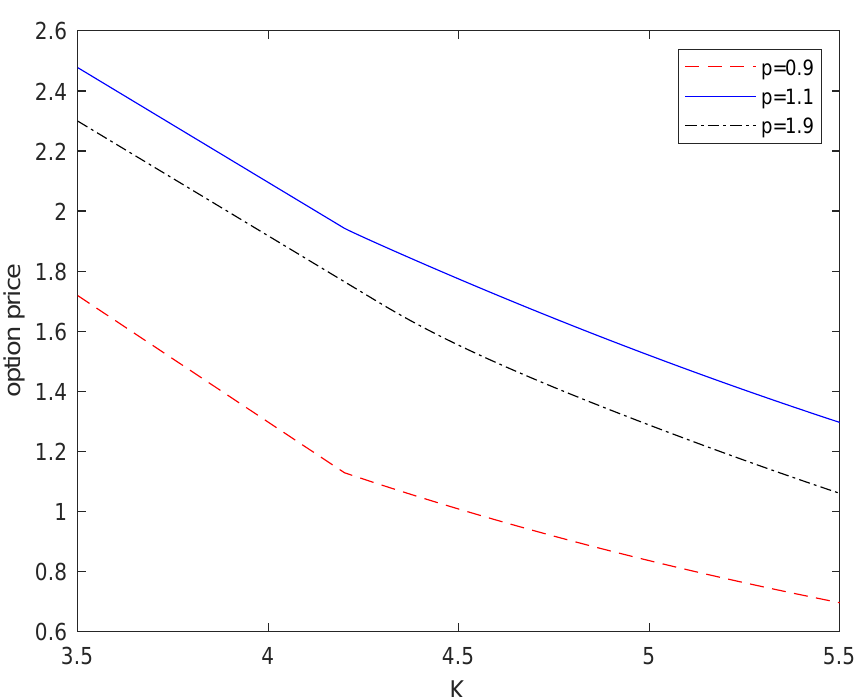
Figure 5. Price of the option with different K in [ 3.5,5.5 ] while p is constant.